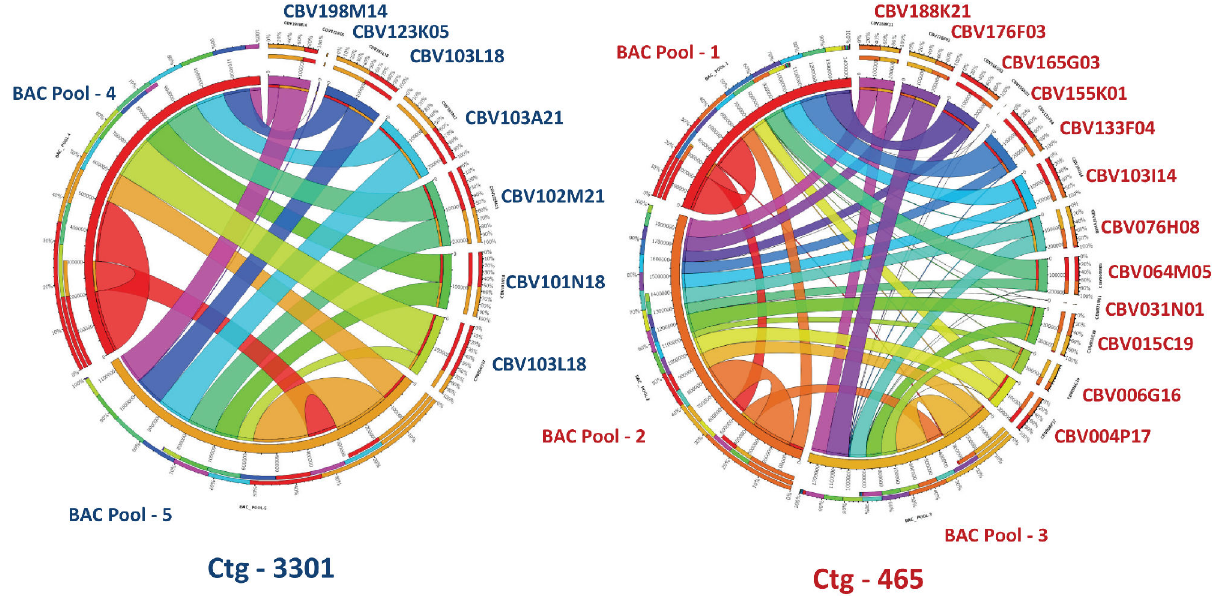
Figure 2. Diagrammatic representation of BAC-pools and their homology across the pools and respective BAC clone ABI assemblies in Ctg-3301 and